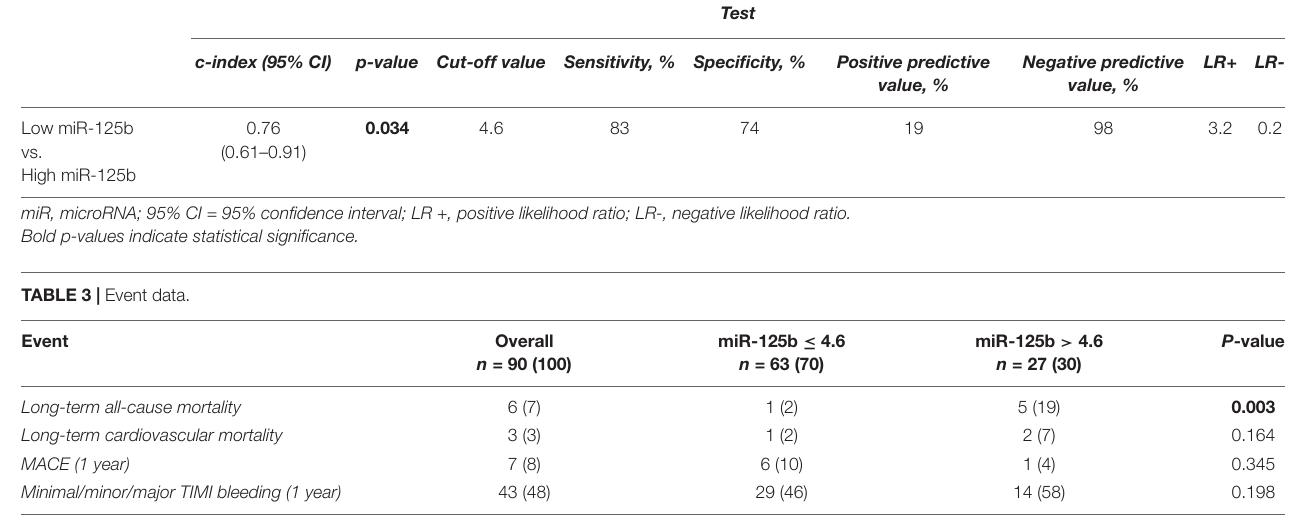
TABLE 2 | Statistical estimates for the prediction of long-term all-cause mortality depending on miR-125b expression levels. Long-term all-cause mortality n= 6 (6.7%)